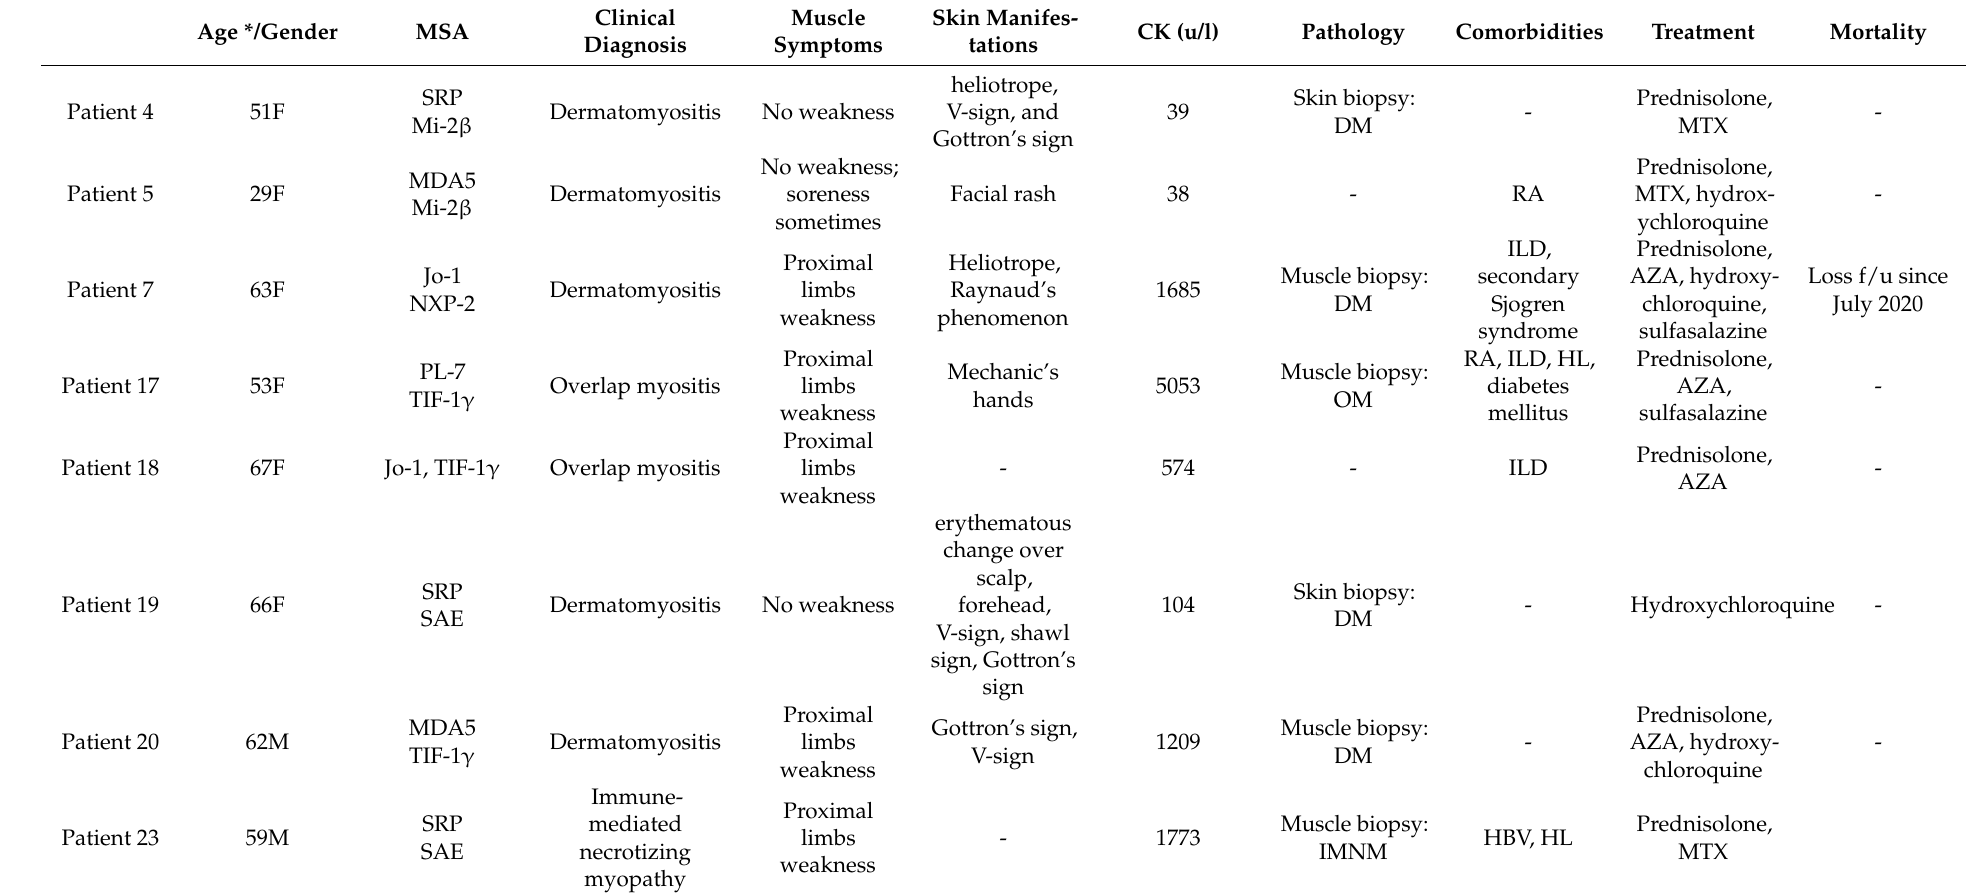
Table 3. Summary of clinical features of 8 patients of IIM with double positive